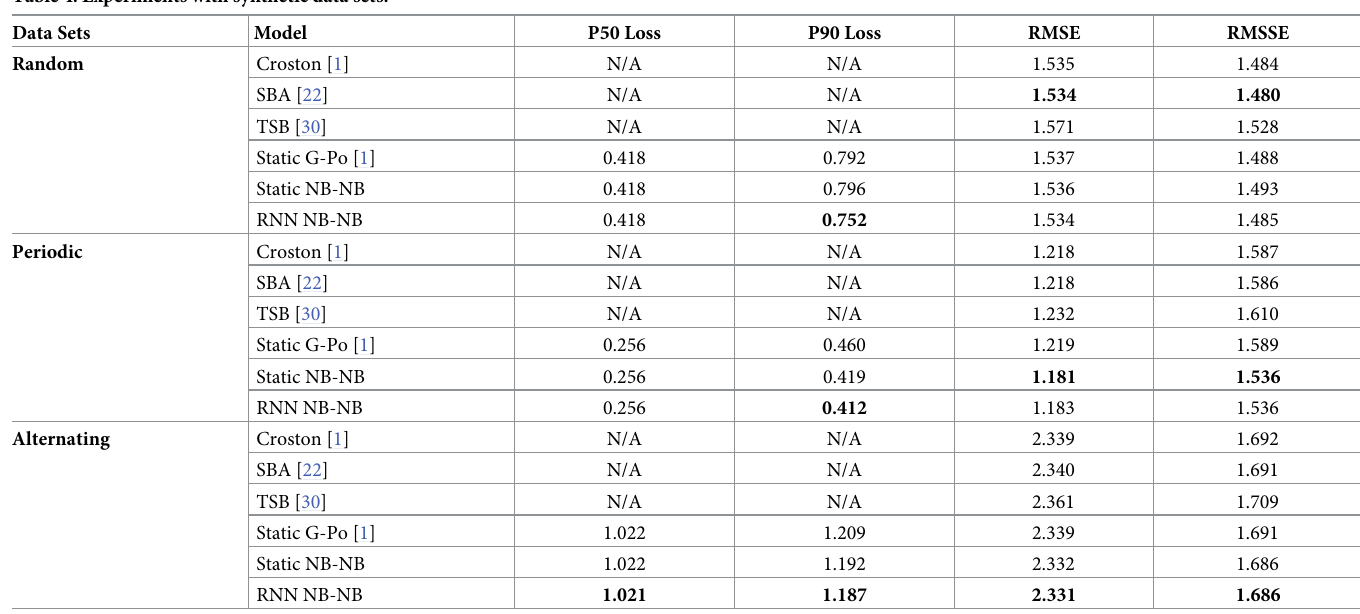
Table 4. Experiments with synthetic data